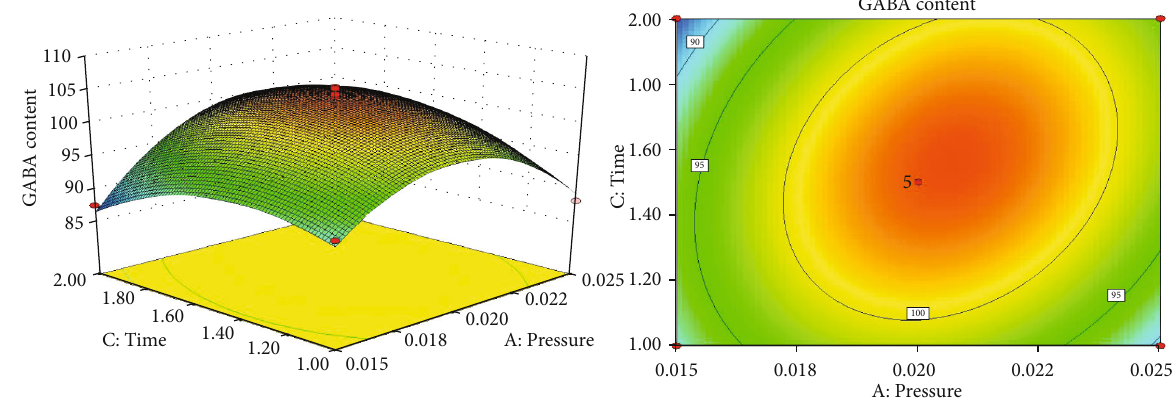
Figure 17: Response surface and contour diagram of pressure and time in fl uence on GABA